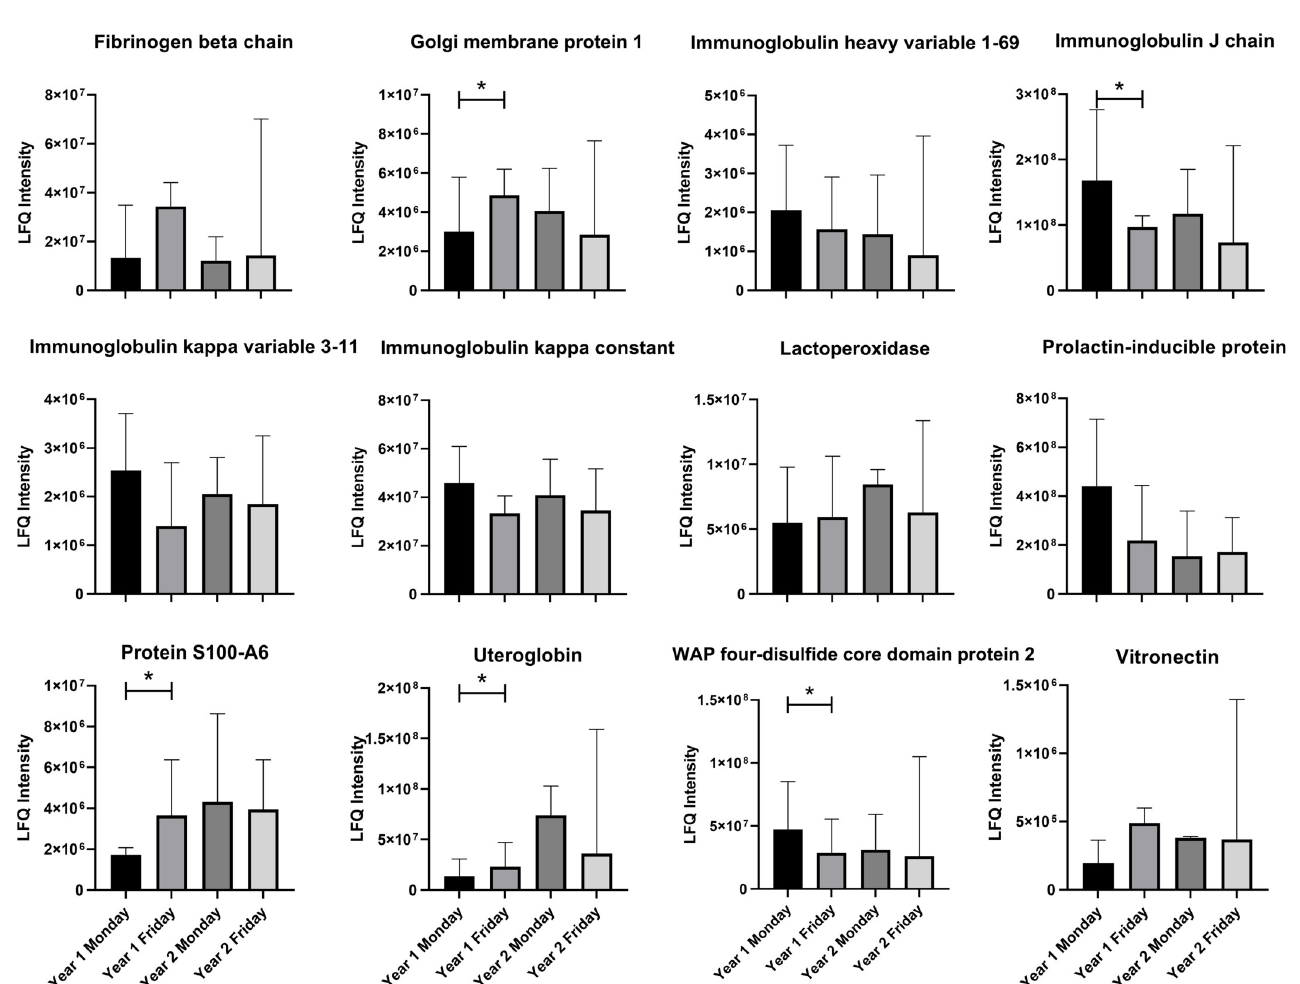
Fig 3. Comparison of protein differences in nasal lavage fluid collected from additive manufacturing operators year 1 and year 2. Values are median (range), LFQ–label free quantification, � p < 0.05 Wilcoxon matched pairs test.